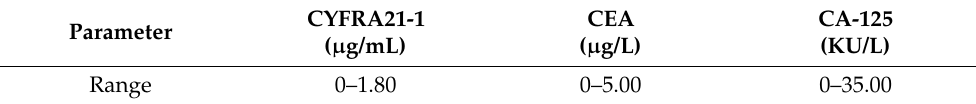
Table 2. Three highly relevant NSCLC diagnostic and decision parameters and their normal ranges.